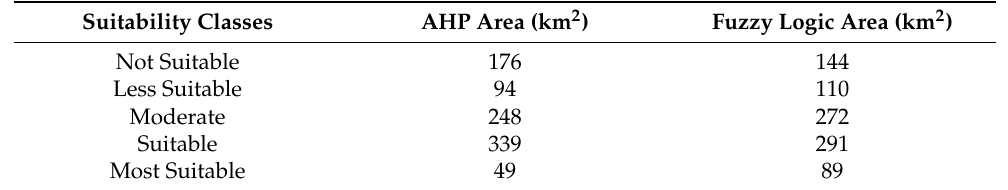
Table 9. Area of suitability classes from both the